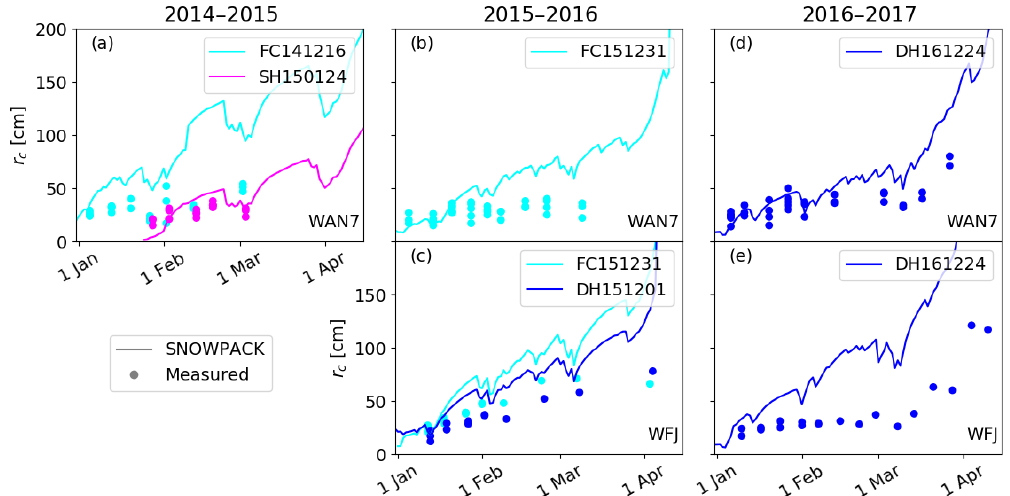
Figure 5. Evolution of the critical crack length r c for the winter seasons 2014–2015 ( a WAN7), 2015–2016 ( b WAN7; c WFJ), and 2016– 2017 ( d WAN7; e WFJ). Dots represent mean measured r c values from PST experiments, and lines represent modeled r c values with layer properties from SNOWPACK using Eq. (2).